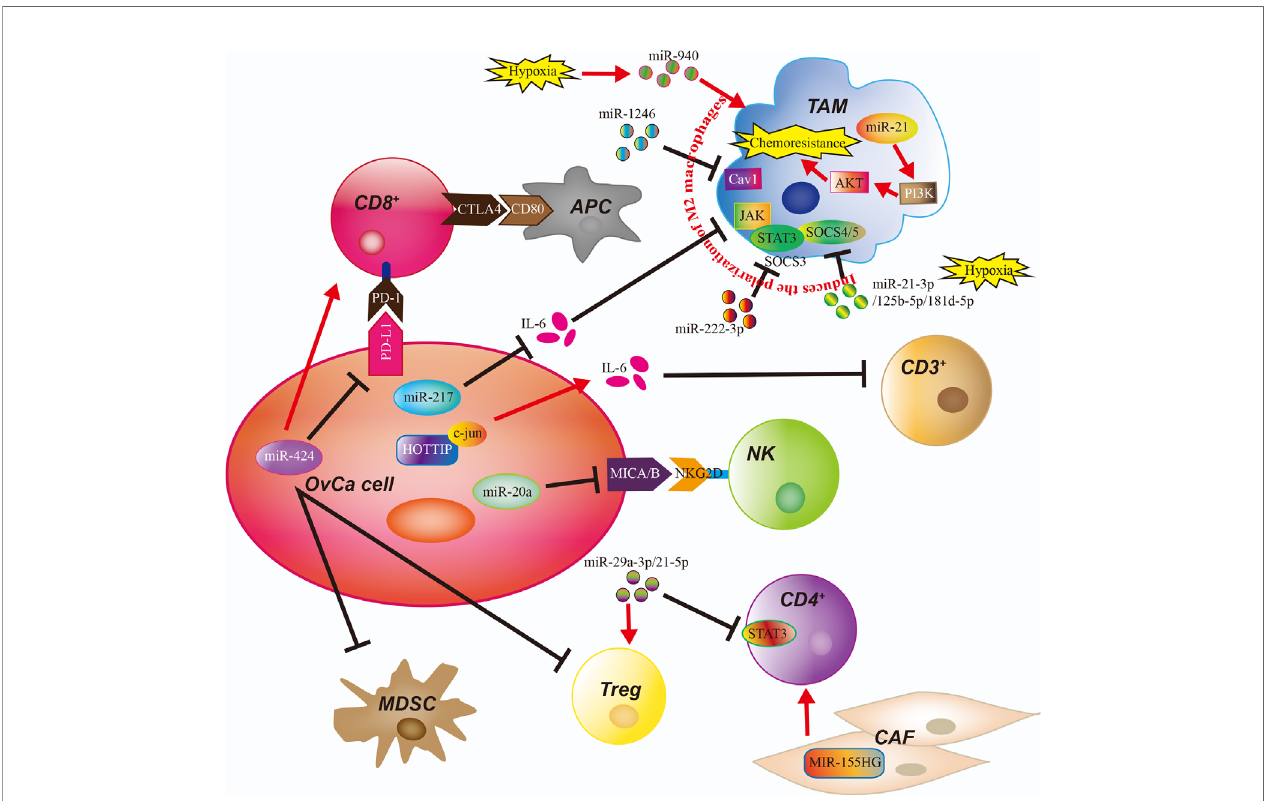
FIGURE 2 | The Role of Noncoding RNAs in the Ovarian Cancer Tumor Microenvironment. The immune cells of the ovarian cancer (OvCa) tumor microenvironment are regulated by noncoding RNAs and exosomes containing micro-RNAs (miRs). APC, antigen-presenting cell; CAF, cancer-associated fi broblast; CD3 + , CD3- expressing T cell, CD4 + , CD4-expressing T cell; CD8 + , CD8-expressing T cell; MDSC, myeloid-derived suppressor cell; NK, natural killer cell; TAM, tumor-associated